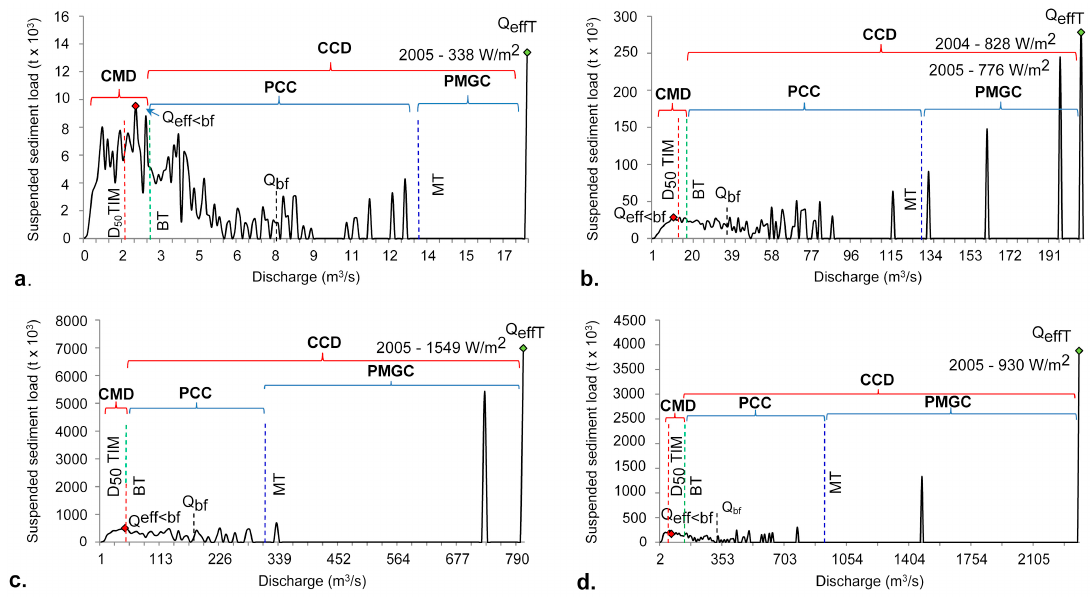
Figure 12. Differentiation between channel-maintaining and channel-changing discharges based on specific thresholds of stream power. ( a ) Lunca de Sus; ( b ) Goioasa; ( c ) Târgu Ocna; ( d ) Vrânceni.